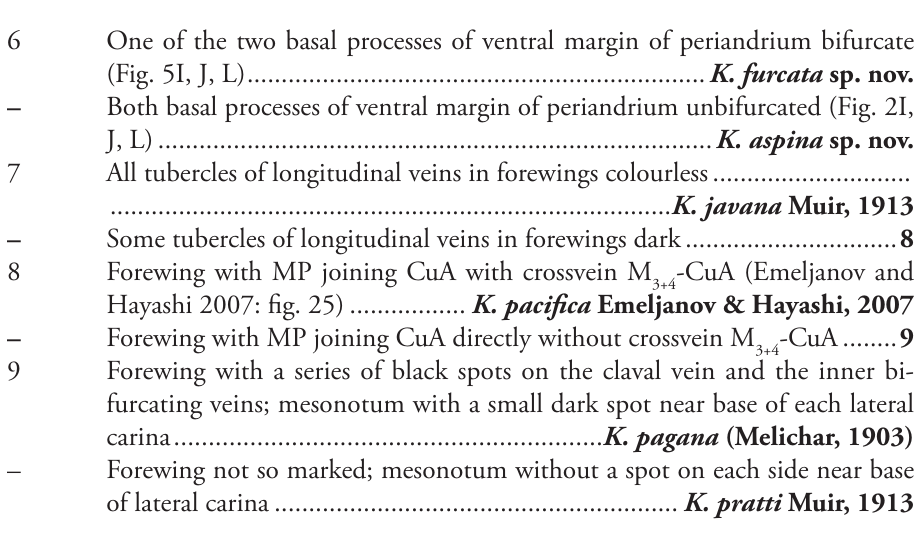
Type material. Holotype : ♂ , China: Hunan Province, Wugang City, Yunshan Nation- al Forest Park (26°40'N, 110°37'E), 5 June 2011, leg. Xiang-Sheng Chen; Paratypes : 8 ♂♂ 7 ♀♀ , same data as holotype. Coloration . General color light brown (Figs 1A–E, 3J, K). Eyes blackish brown, ocelli light yellow, semitransparent. Vertex generally yellowish white. Face gener- ally dark brown; rostrum light brown. Pronotum with discal areas and mesonotum with area between lateral carinae yellowish white, lateral areas brown. Forewing light brown, semi-translucent. Stigma light brown. The basal half dotted with small dark brown spots and distal half with two large dark brown patches; small dark brown spots on the ends of longitudinal veins. Hind tibiae and abdominal sternites yellowish brown. Head and thorax . Vertex (Figs 1C, 2A) broad, 2.2 times wider than long; an- terior margin truncated, posterior margin arched and recessed. Frons (Figs 1D, 2B) widest at the level of antennae, as long as wide; frontoclypeal suture nearly concave elevated. Rostrum distinctly surpassing hind coxae, subapical segment 2.5 times longer than apical segment. Pronotum (Figs 1C, 2A) 2.4 times longer than vertex; median carina indistinct, posterior margin nearly at right angle. Mesonotum 1.7 times longer than pronotum and vertex combined. Forewing (Fig. 2C) 2.4 times longer than wide, with 10 apical and 6 subapical cells; fork Sc+RP slightly basad of fork CuA +CuA , first crossvein r-m at same level of fork MP, RP two branches, 1 2